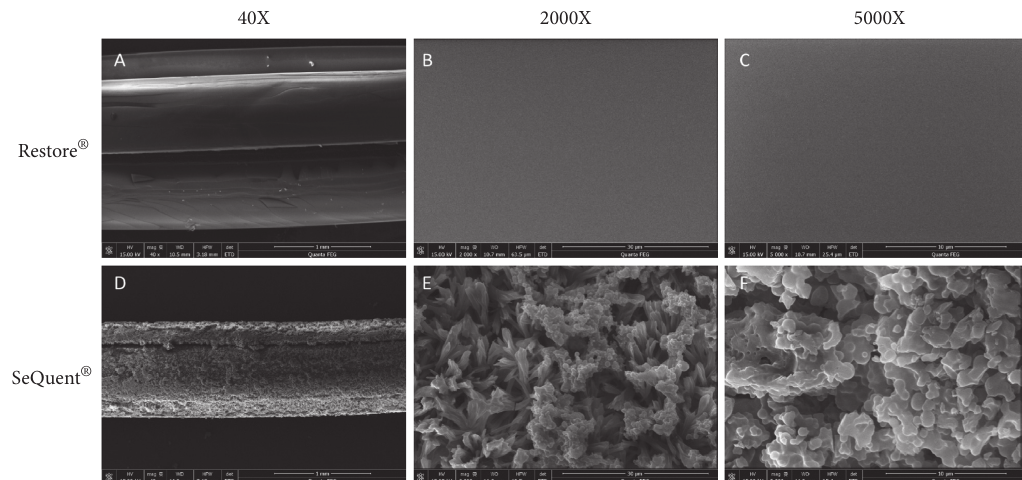
Figure 1: Representative electron microscopical images of Restore ® versus SeQuent ® Please balloon. Coating integrity of Restore ® ((a) 40X, (b) 2000X, and (c) 5000X) balloons was complete, and the surface was smooth and evenly distributed with hardly visible crystal. SeQuent ® Please ((d) 40X, (e) 2000X, and (f) 5000X) balloons had a rougher surface with relatively larger apparent crystals. Scale bars are 1 mm (a, d), 3 μ m (b, e), and 10 μ m (c, f).